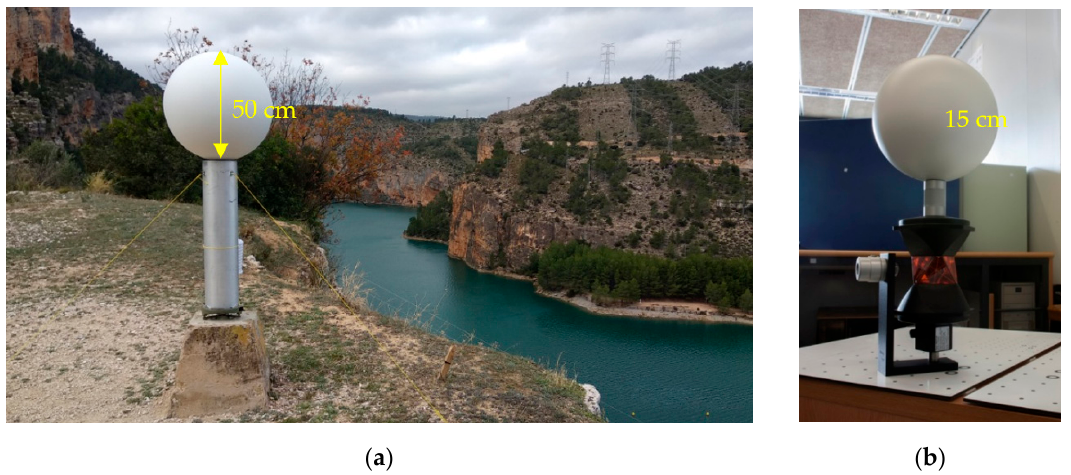
Figure 2. Example of target devices used on pillars of the reference frame and check points used for monitoring the site: ( a ) 50 cm white spherical point on the pillar (number 8005); ( b ) check point (in the center of the 360° prism) with a 15 cm white sphere on top. Please note both images are not to the same scale.